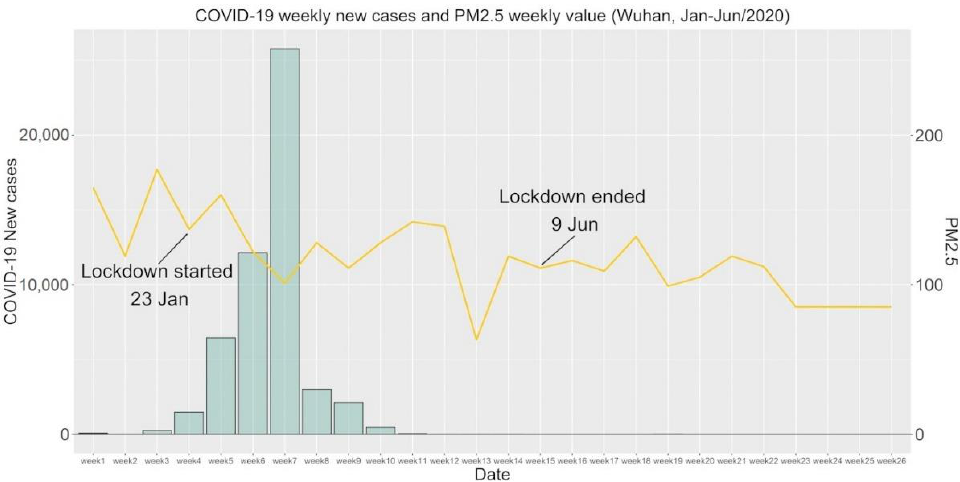
Figure 7. Weekly new COVID-19 cases and weekly PM2.5 values (Wuhan, Jan – Jun/2020).